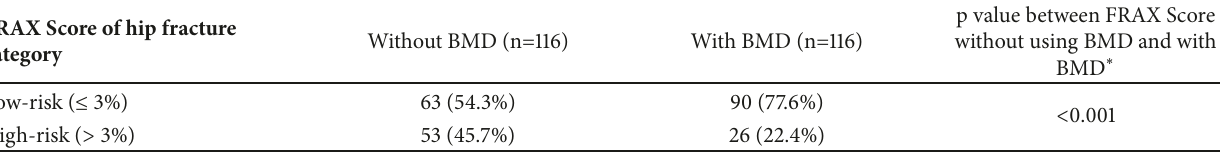
Table 3: The 10-year probability of hip fracture. Without vs with using BMD on calculation.